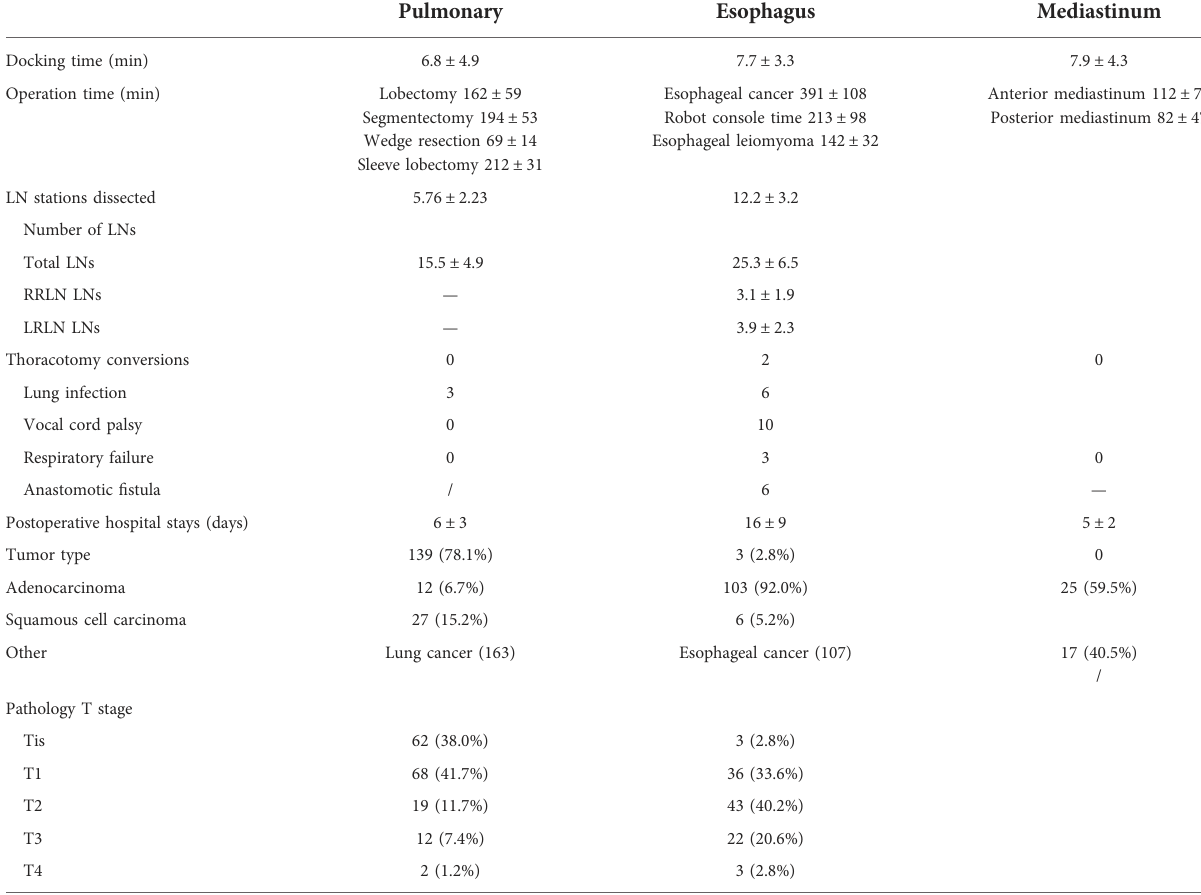
TABLE 2 Perioperative